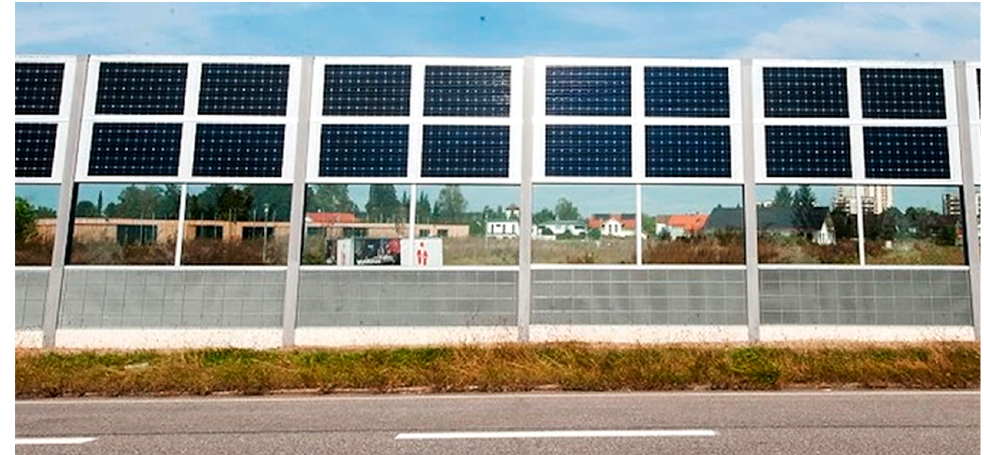
Figure 20. PVNB in Neuötting, built by Maxsolar company [63].